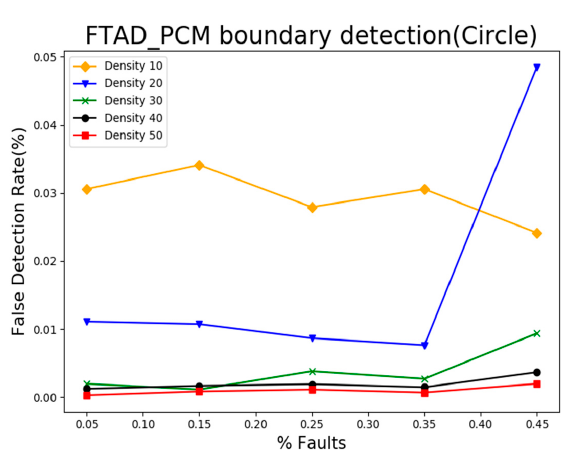
Figure 7. FTAD_PCM boundary false detection (circle).